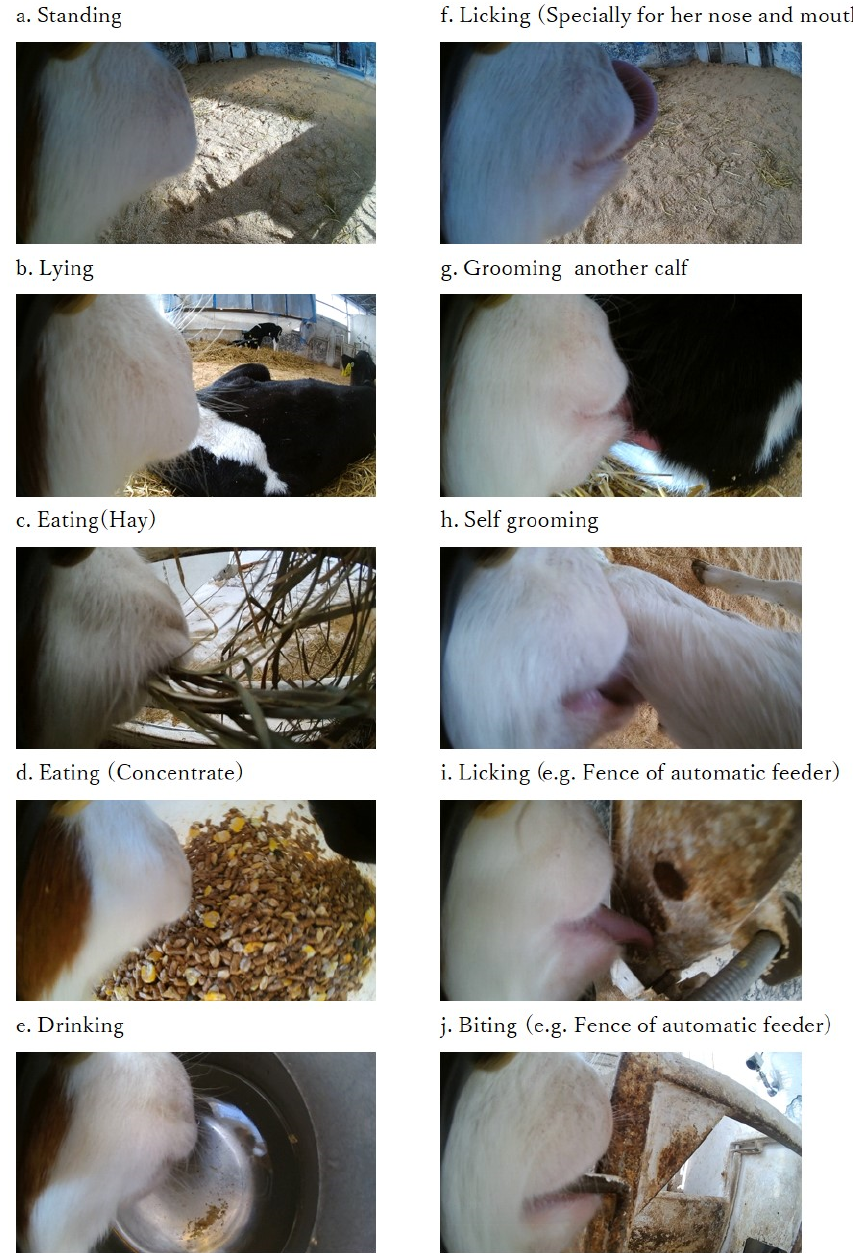
Figure 3. Representative images (calf No. 876) captured using a wearable camera for monitoring juvenile bovine behavior. The camera was fixed to the halter on the right cheek of the calf. Titled behaviors were recorded.